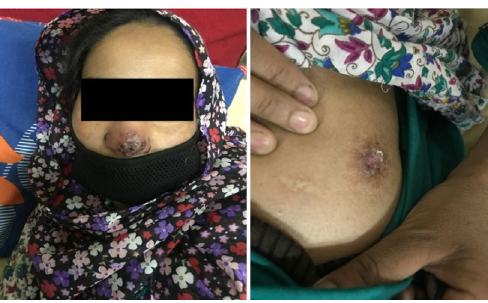
image 1. 30 yr old female with indurated, crusted plaques with erythematous base present over (a) Nasal bridge, right nasal alae (b) Left gluteal region. Both lesions were non-tender. (Original table 3. Age and gender-wise distribution of patients with suspected lesions Age group